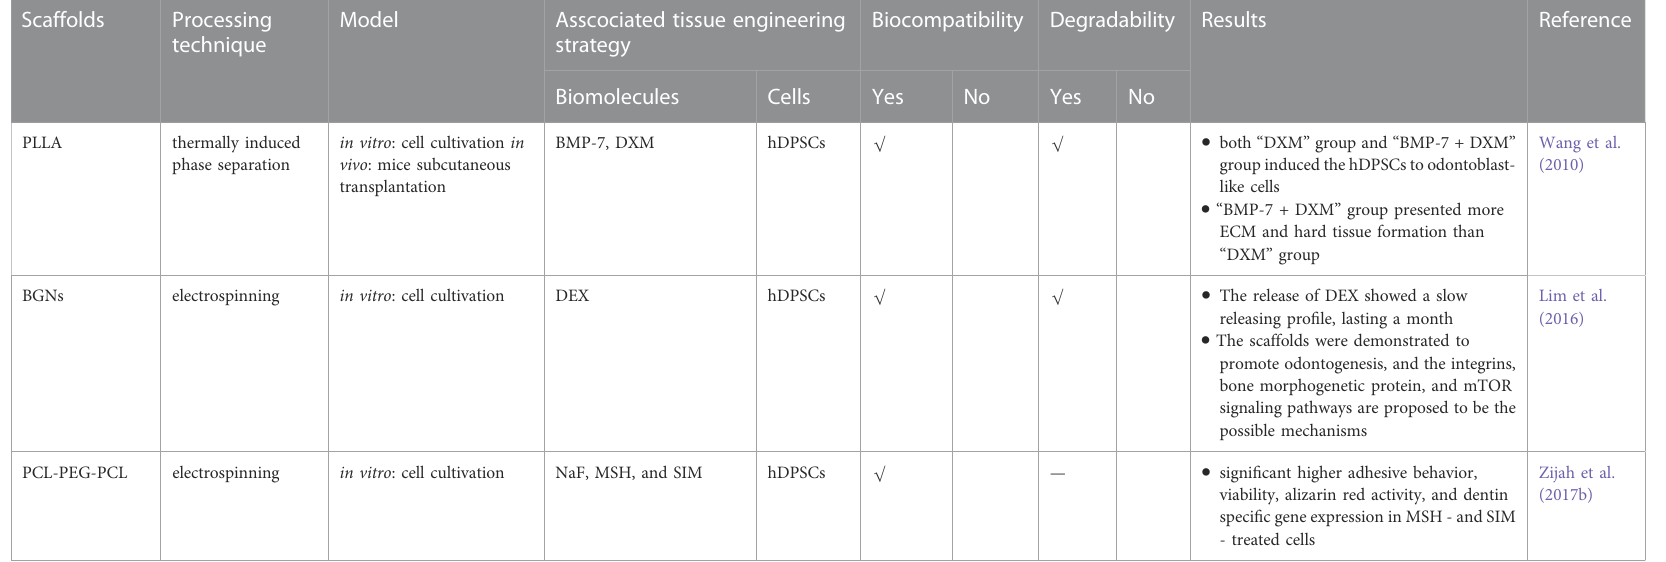
Wang et al. (2010) Lim et al. (2016)